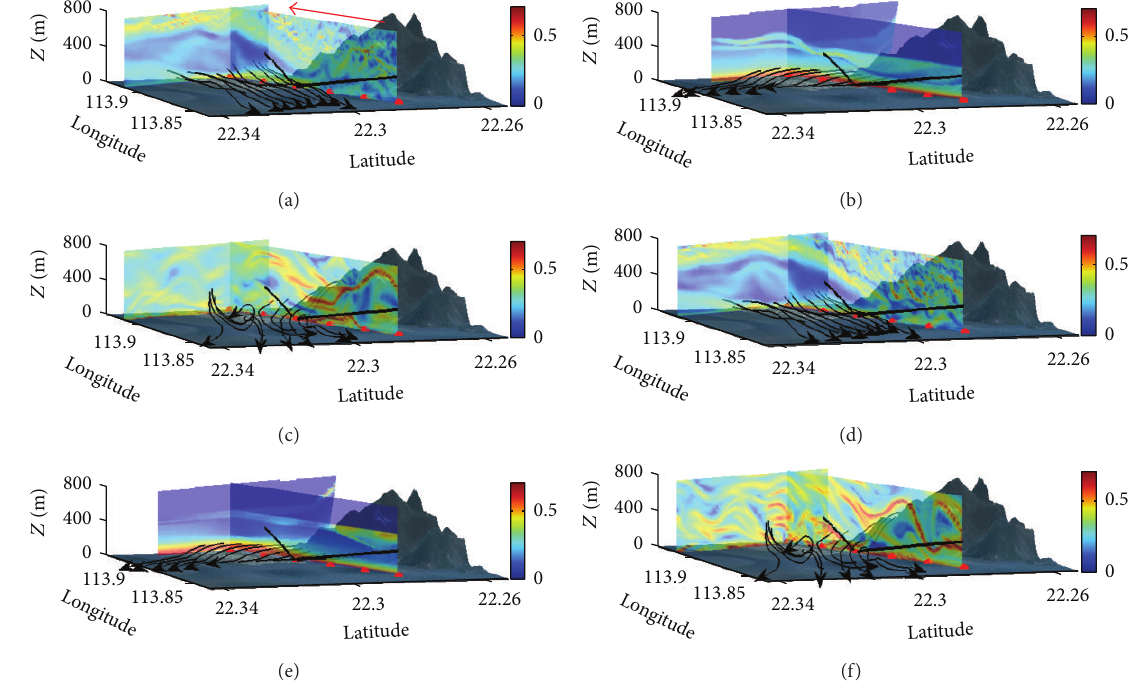
Figure 2: Lagrangian coherent structures from different data sets and their relative positions to the Lantau island. The opaque color maps are the vertical slices of the FTLE fields along and perpendicular to the runways, intersecting at the southern runway threshold towards the west. The thick black curve in each panel is the airplane landing trajectory. The thin black curves are fluid trajectories highlighting the structures, with black arrows indicating direction of flow. The panels are, from left to right, data from RAMS, FLOWSTAR, and WRF, respectively. The top panels are the forward time FTLE and the bottom panels are the backward time FTLE. Axes are given in (d). The red arrow indicates direction of flight. The red dots on sea surface level mark every nautical mile towards the runway threshold. The runway threshold is located at the lowest point of the flight